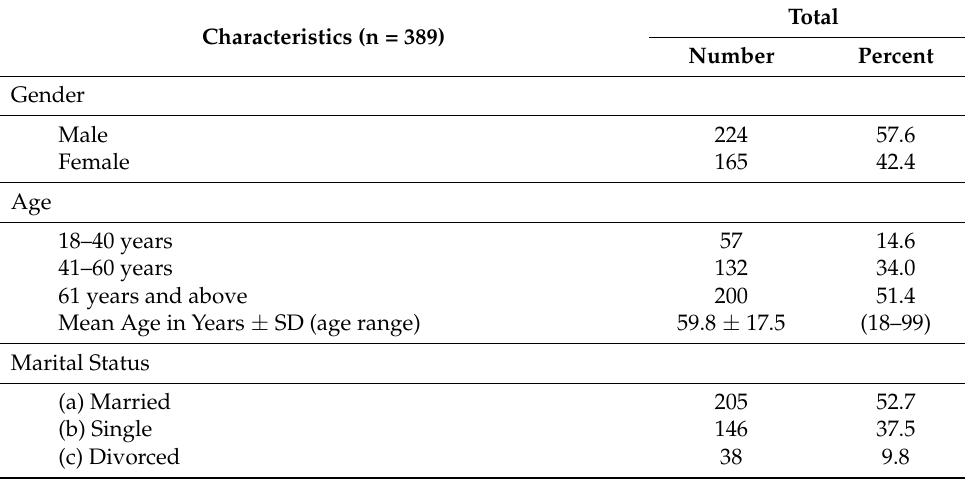
Table 1. Characteristics of critical post-general surgery patients during first 24 h.